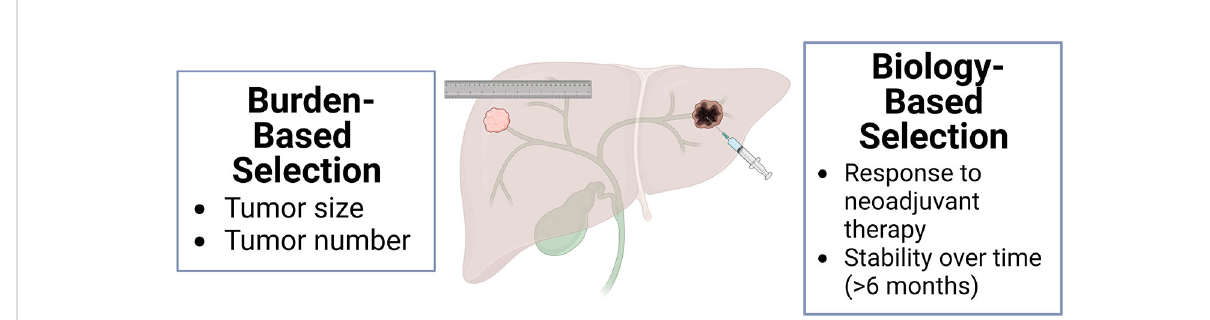
FIGURE 3 Selection criteria for liver transplantation for iCCA, burden-based and